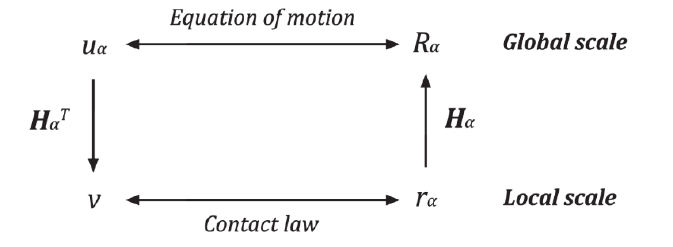
Figure 7: Global and local mapping in the NSCD algorithm